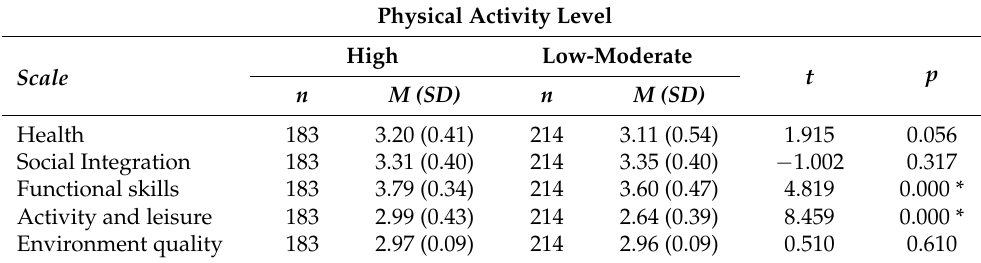
Table 1. Mean, standard deviations, and t -test of the scores on the scales of health, social integra- tion, functional abilities, activity and leisure, and environmental quality according to the level of physical activity.